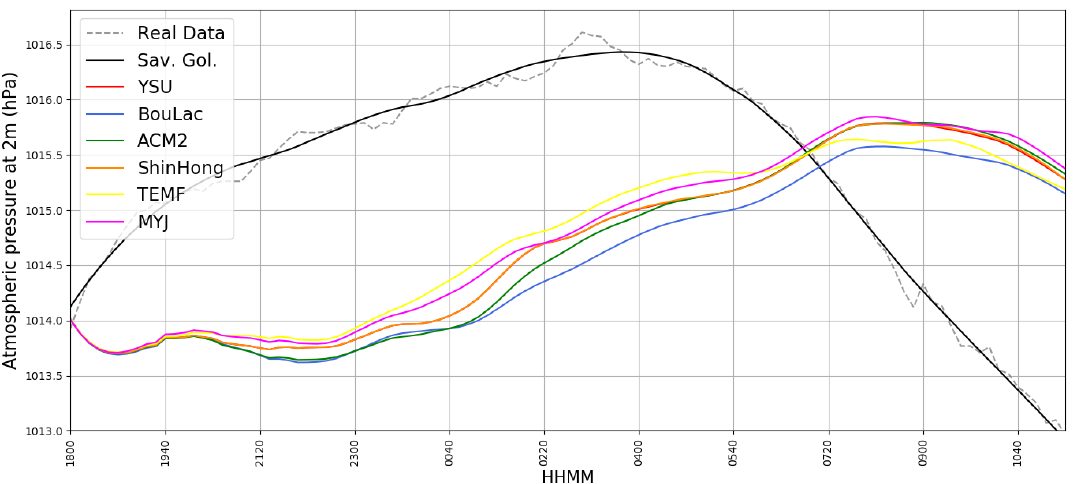
Figure 14 . Simulated P2M timeseries compared with real GL P2M timeseries, 17/05/2017, dotted grey: real data, black: Savitsky – Golay smoothing of real data, red: simulated data with YSU parametrization, blue: simulated data with BouLac parametrization, green: simulated data with ACM2 parametrization, orange: simulated data with ShinHong parametrization, yellow: simulated data with TEMF parametrization, purple: simulated data with MYJ parametrization.